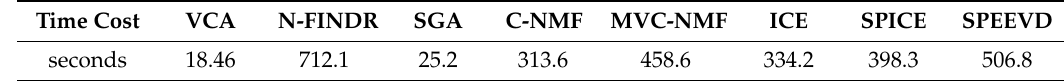
Table 9. The average running time of all methods on Cuprite image.